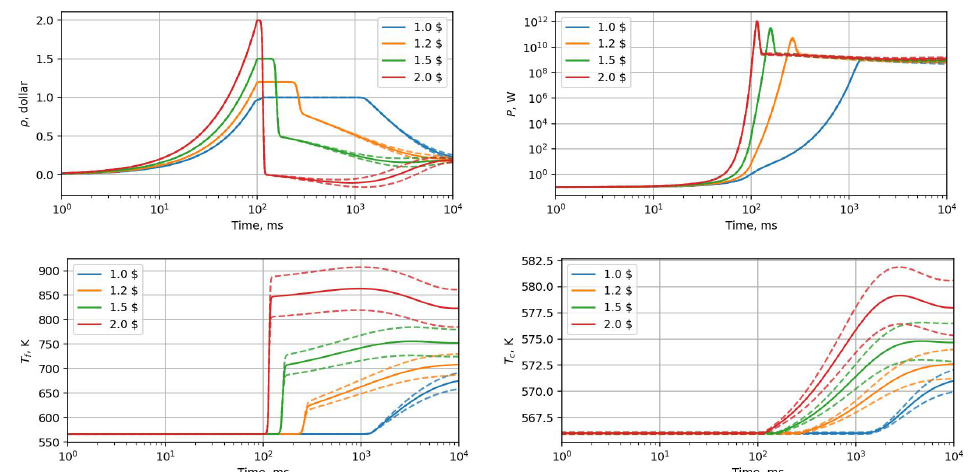
Figure 1. Reactivity, power and temperature transients due to the ejection of a control rod at HZP; the dotted lines show the 3 σ percentile that accounts for